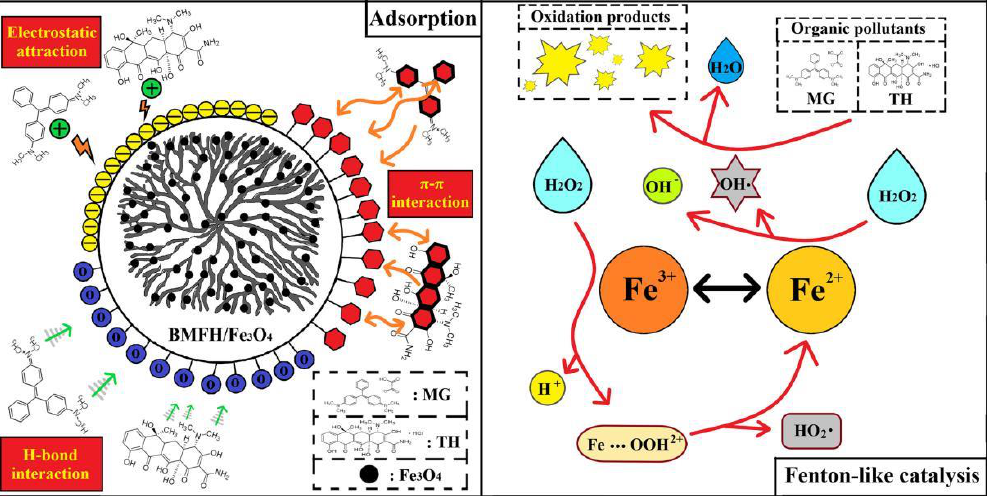
Figure 13. Possible mechanisms of BMFH/Fe 3 O 4 for removal of MG and TH via adsorption and Fenton-like catalysis.